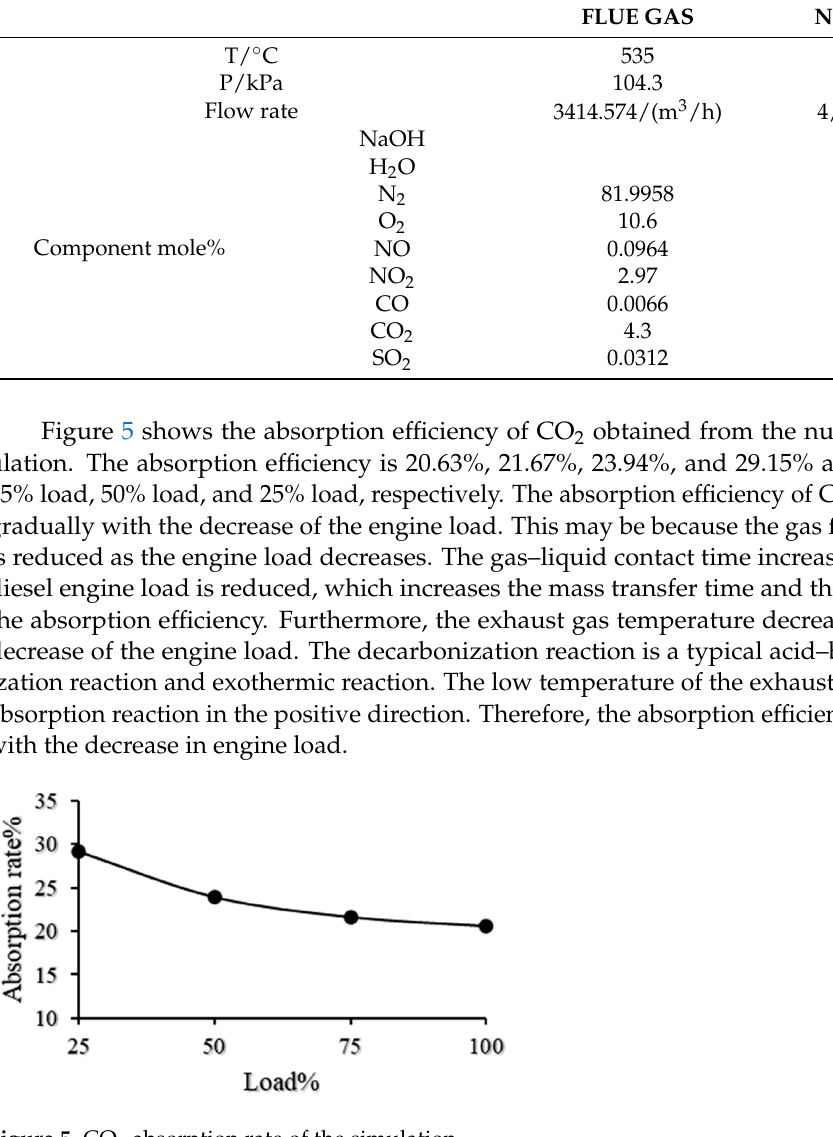
Figure 5. CO 2 absorption rate of the simulation.